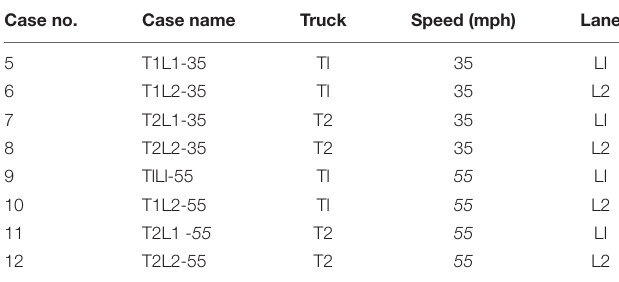
TABLE 3 | Dynamic loading